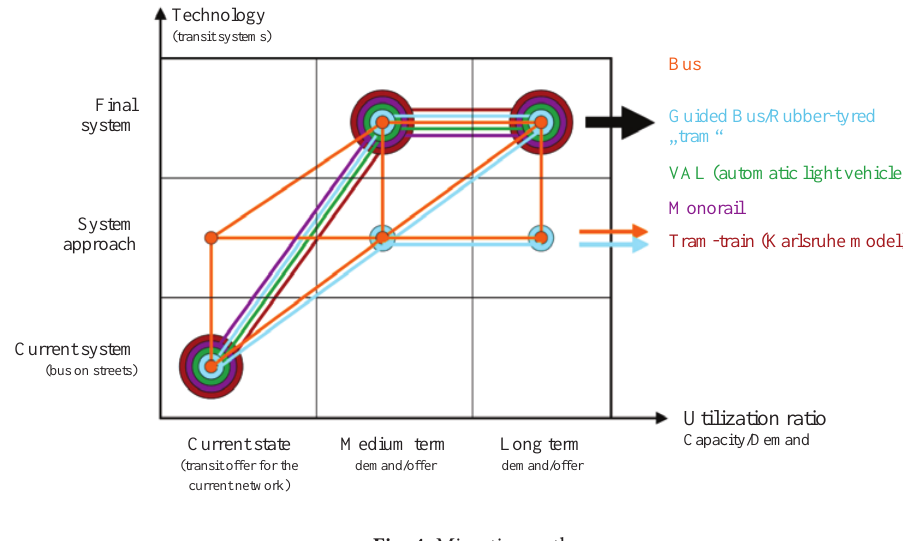
Fig. 4. Migration path